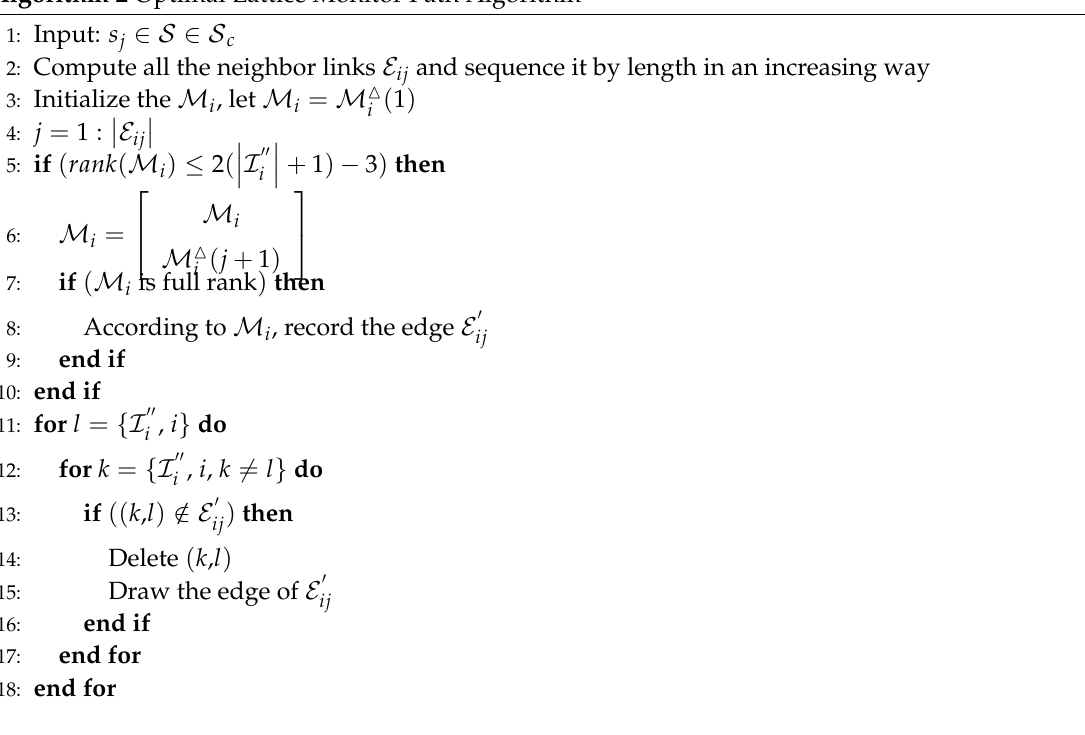
Algorithm 2 Optimal Lattice Monitor Path